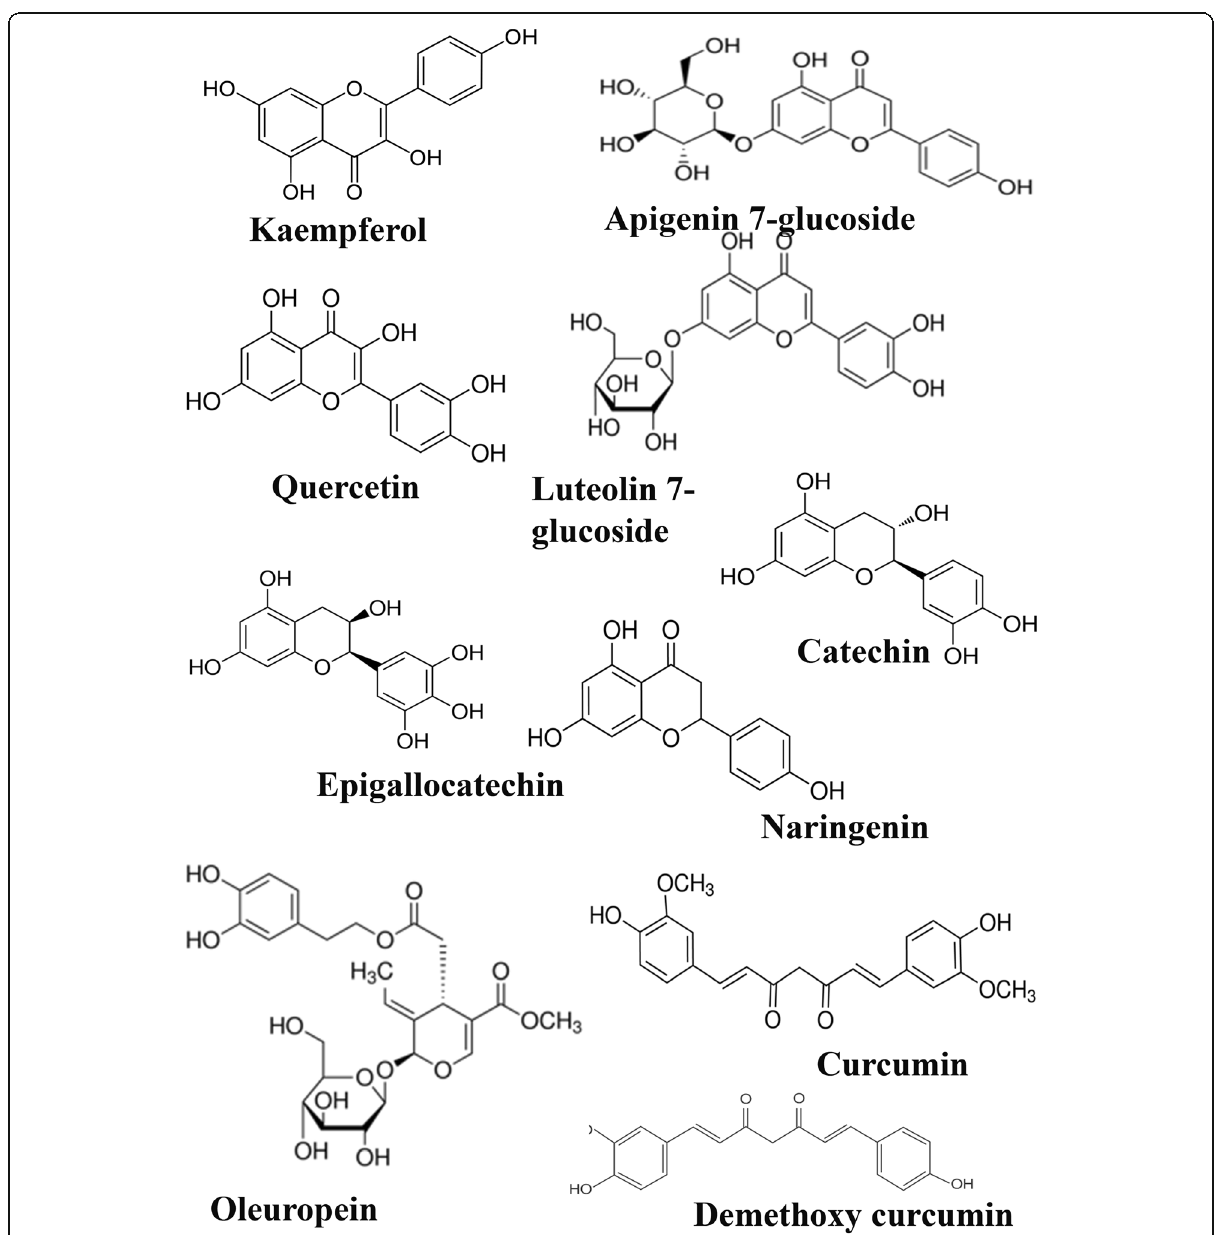
Fig. 5 Suggested flavonoid inhibitors of the SARS CoV-2 main